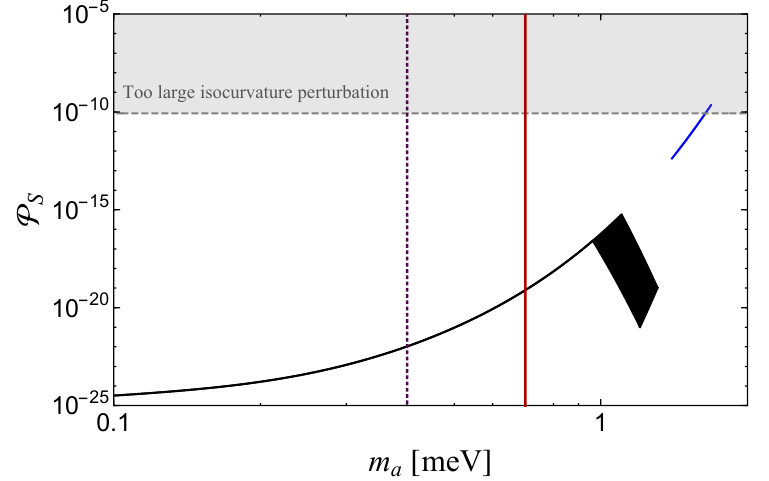
Figure 6 . The axion isocurvature perturbation predicted by the (cid:25) n(cid:13)ation model (3.1) with n inf = 2 (black) and n inf = 3 (blue). The in(cid:13)ation scale decreases as m a increases (cf. (cid:12)gure 4). The pre- dicted isocurvature increases for m a . 1 meV because (cid:18) i approaches (cid:25) , which overcomes the decrease of H inf (see eqs. (2.14) and (3.19)). On the other hand, the deviation from the hilltop is determined by the in(cid:13)aton dynamics for m a & 1 meV, and the predicted in(cid:13)ation scale sharply drops, lead- ing to the suppression of the isocurvature. The gray region is excluded by too large isocurvature perturbations. The vertical dotted and solid lines represent sensitivity reach of MADMAX and TOORAD,